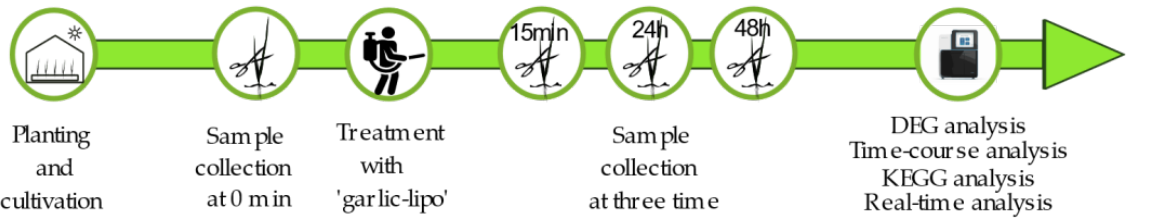
Figure 1. Sample collection at three timepoints of the nanoscale liposome-encapsulated SC-CO 2 garlic extract (‘Garlic-lipo’) on Triticum aestivum in greenhouse experiments. The effects were examined in a large-scale genome-wide transcriptional profiling experiment collecting samples at various timepoints (0 min is the control, and 15 min, 24 h, and 48 h after spaying) and were evaluated by using DEG and time-course expression analysis.